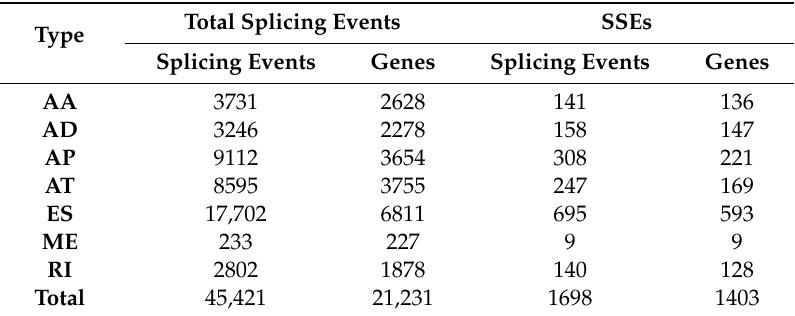
Table 1. Overview of the splicing events in GBC.